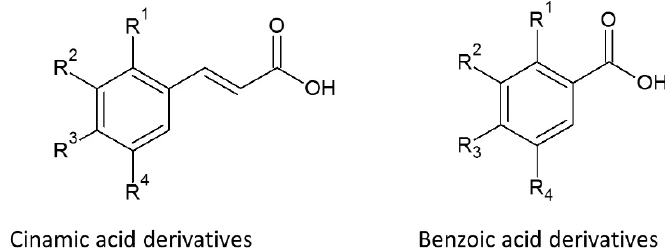
Figure 2. Structures of cinnamic and benzoic acid derivatives. Substitution of the hydroxyl group in the R position leads to the generation of the various phenolic acids. Examples of cinnamic acid derivatives include caffeic acid (R 3 = R 4 = OH), ferulic acid (R 2 = OCH 3 , R 3 = OH) and the benzoic acid derivatives: vanillic acid (R 2 = OCH 3 , R 3 = OH) and gallic acid (R 2 = R 3 = R 4 = OH).